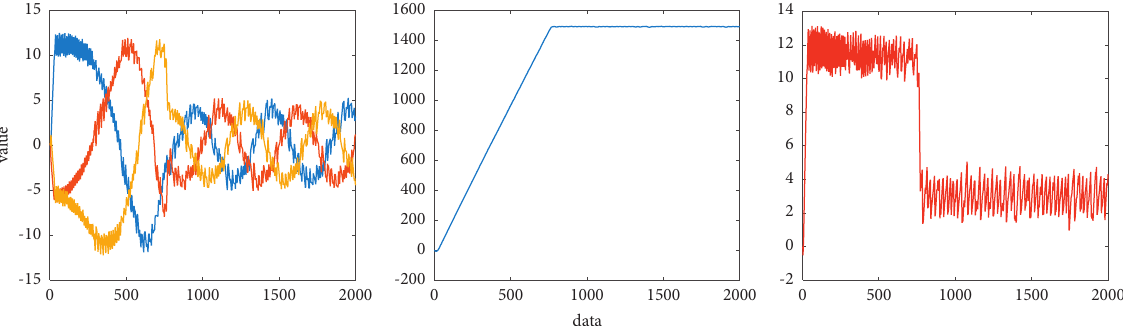
Figure 8: Predicted value.